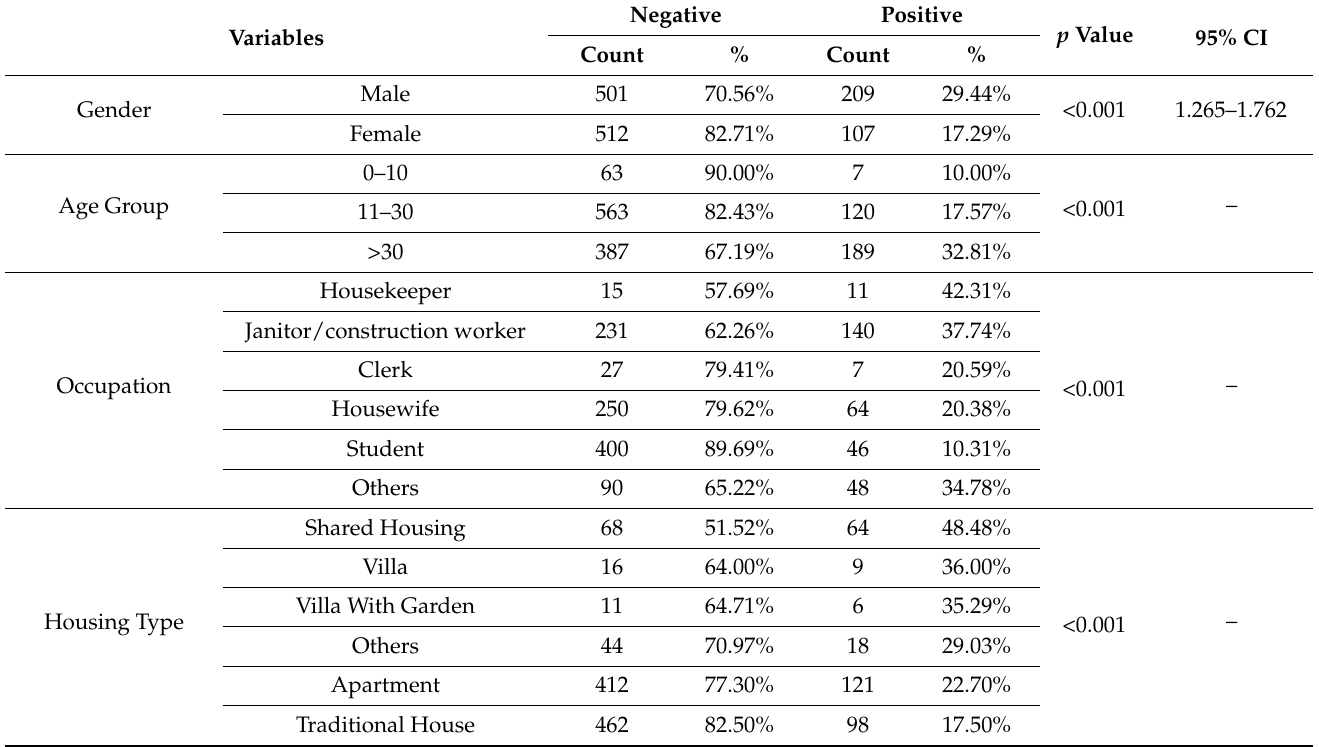
Table 2. Correlation of HEV seroprevalence with demographic and environmental